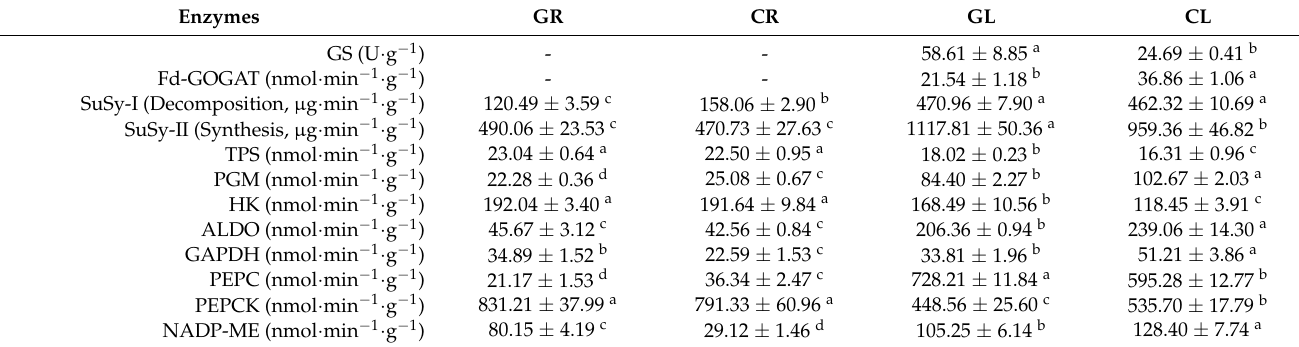
Table 2. The activities of enzymes in tea